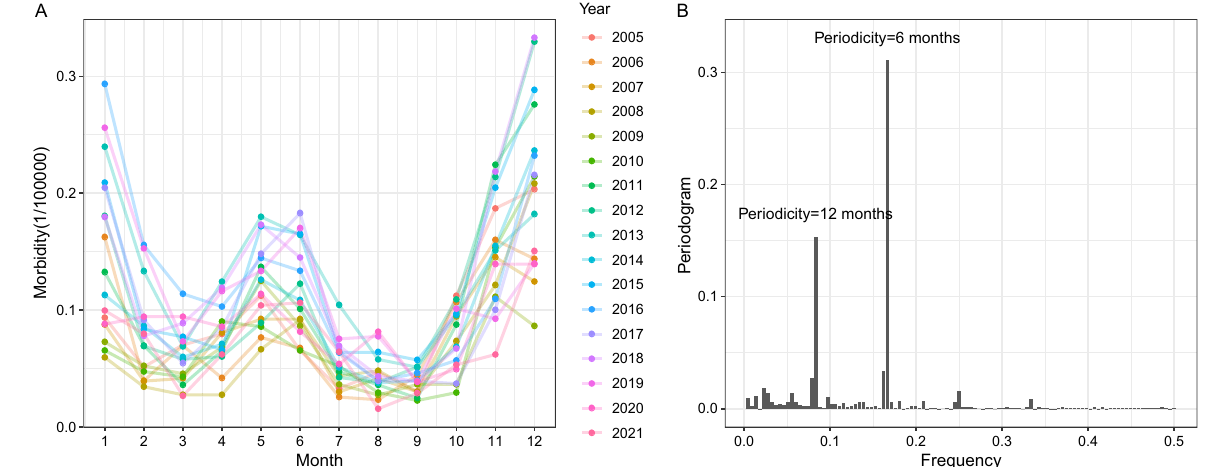
Figure 2. Monthly distribution and the periodogram of HFRS morbidity in Jiangxi from 2005 to 2021.